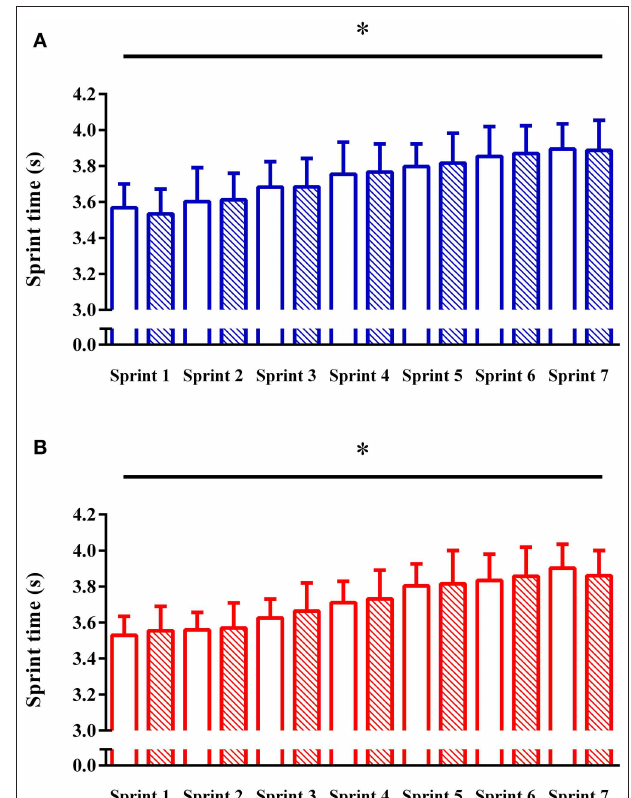
FIGURE 2 | Sprint performance during the RAST for the beta-alanine (A) and placebo (B) groups pre- (clear bars) and post- (striped bars) supplementation. * P < 0.0001. Effect of sprint